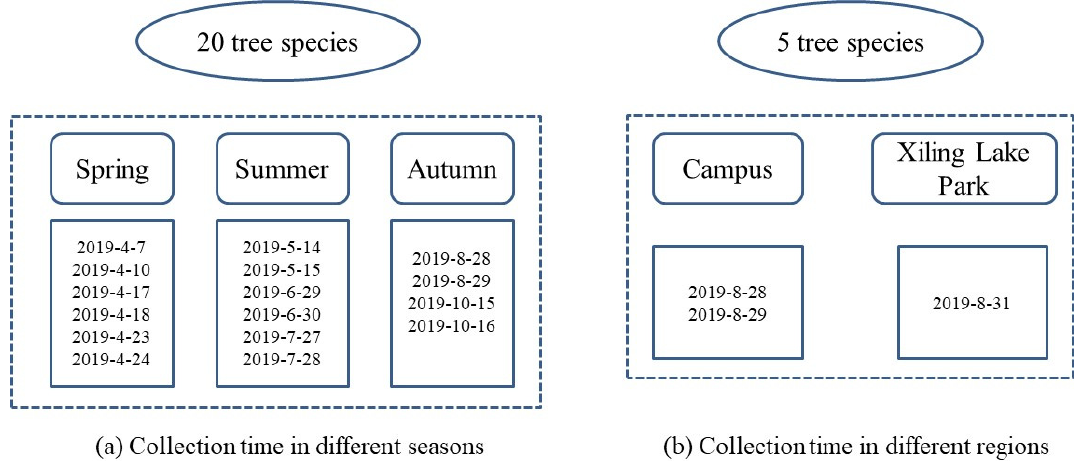
Figure 1. Collection time of samples in different seasons and regions.